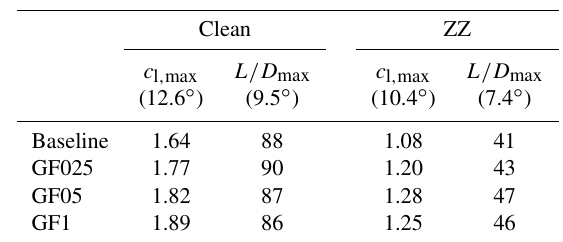
Table C2. DU97W300. Gurney flaps. Characteristic